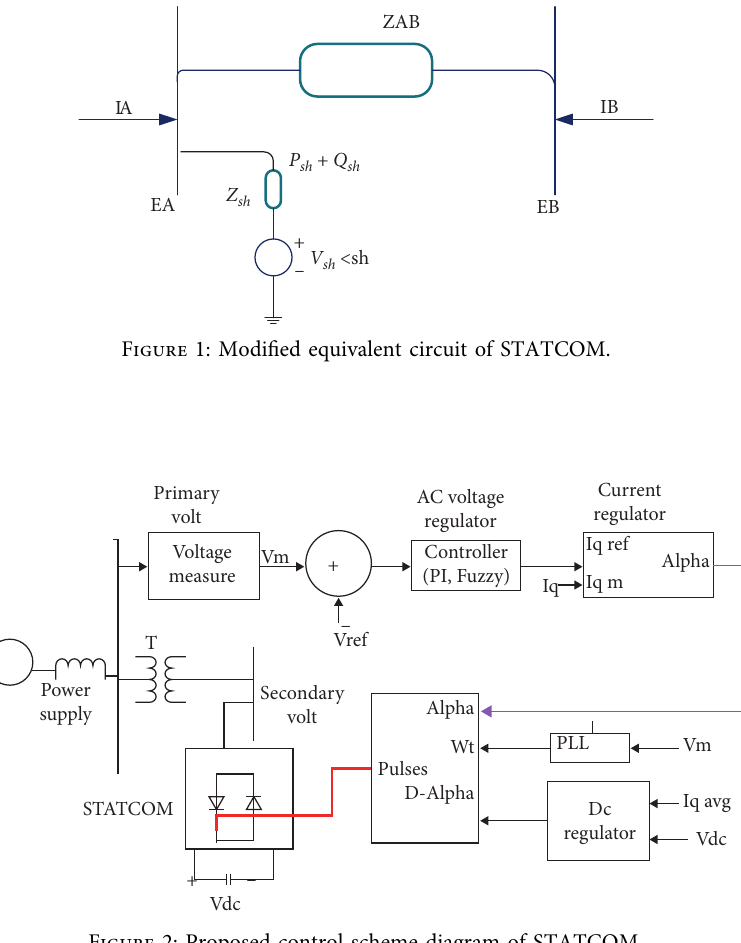
Figure 2: Proposed control scheme diagram of STATCOM.